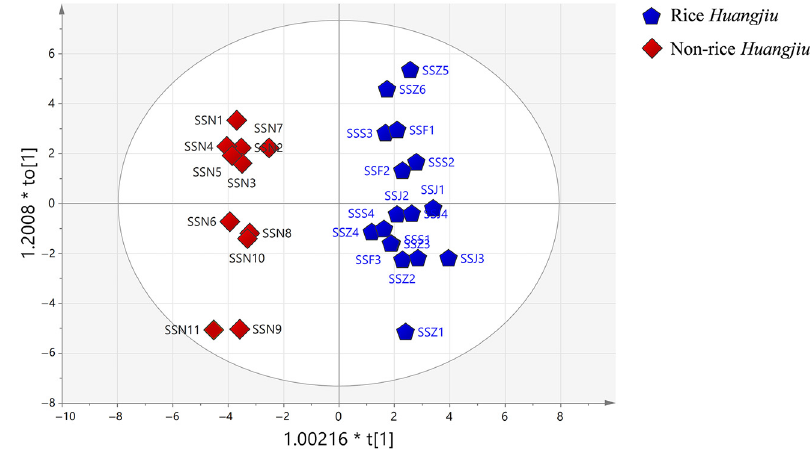
Figure 5. OPLS-DA of rice Huangjiu and nonrice Huangjiu .